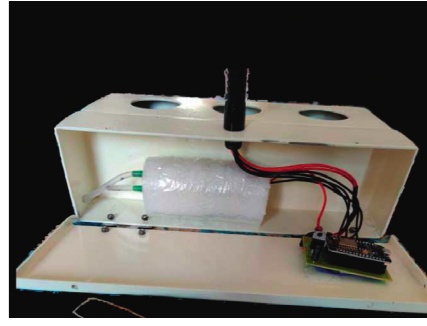
Figure 19: Electronic setup.